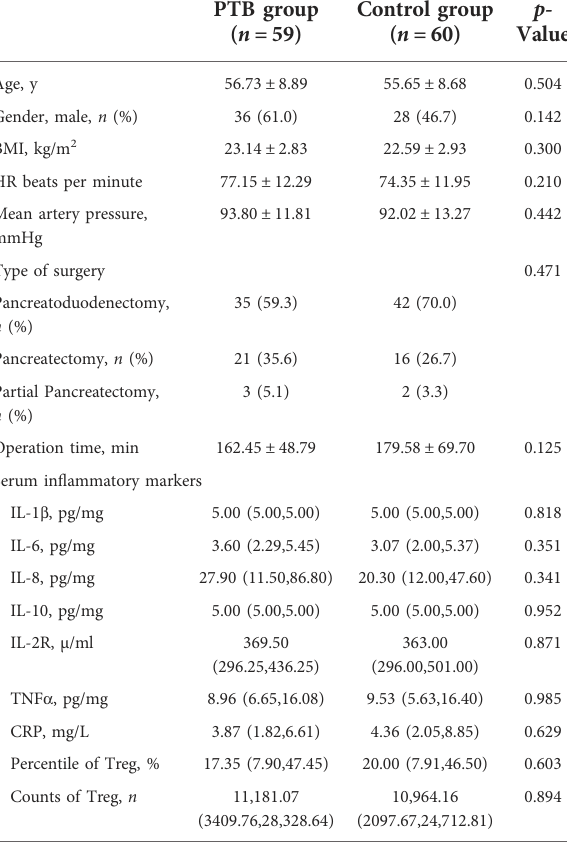
TABLE 3 Measures of secondary outcomes: postoperative biomarkers, pain score, simpli fi ed postoperative nausea and vomiting impact